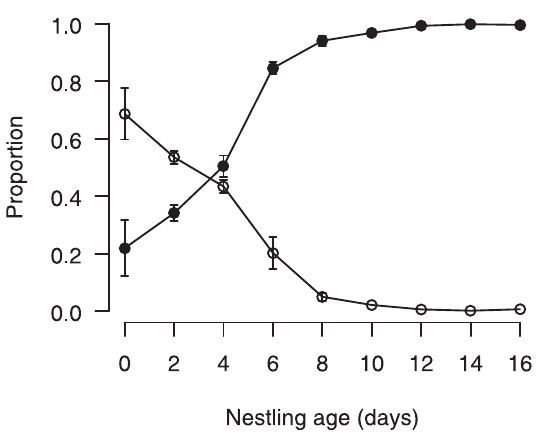
Figure 1. The mean proportion of male feeds direct to nestlings during the nestling period (closed symbols) and the mean proportion of the observation period that the female spends brooding (open symbols). Values are from raw data of control nests ( n =202), SE are indicated.